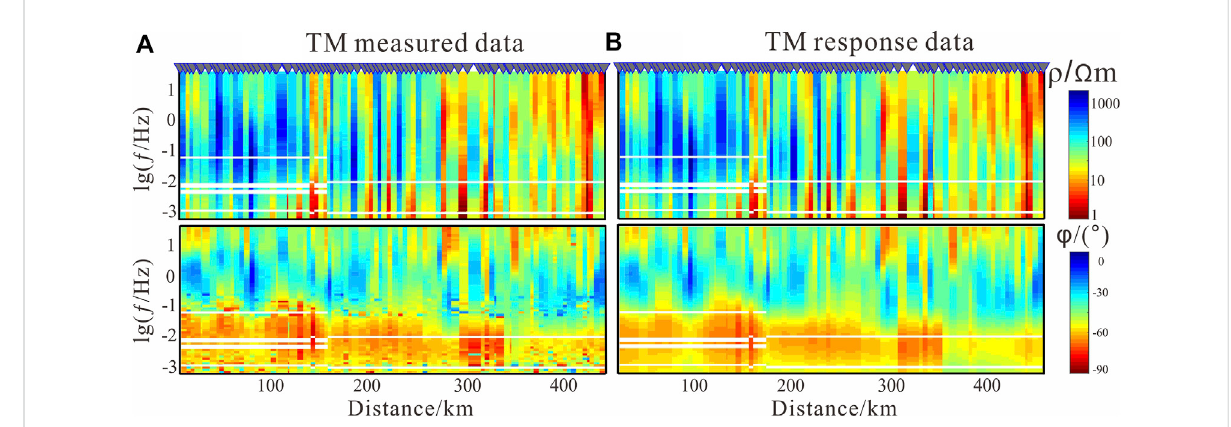
FIGURE 5 Pseudocross sections of (A) observed and (B) modelled TM data of apparent resistivity and